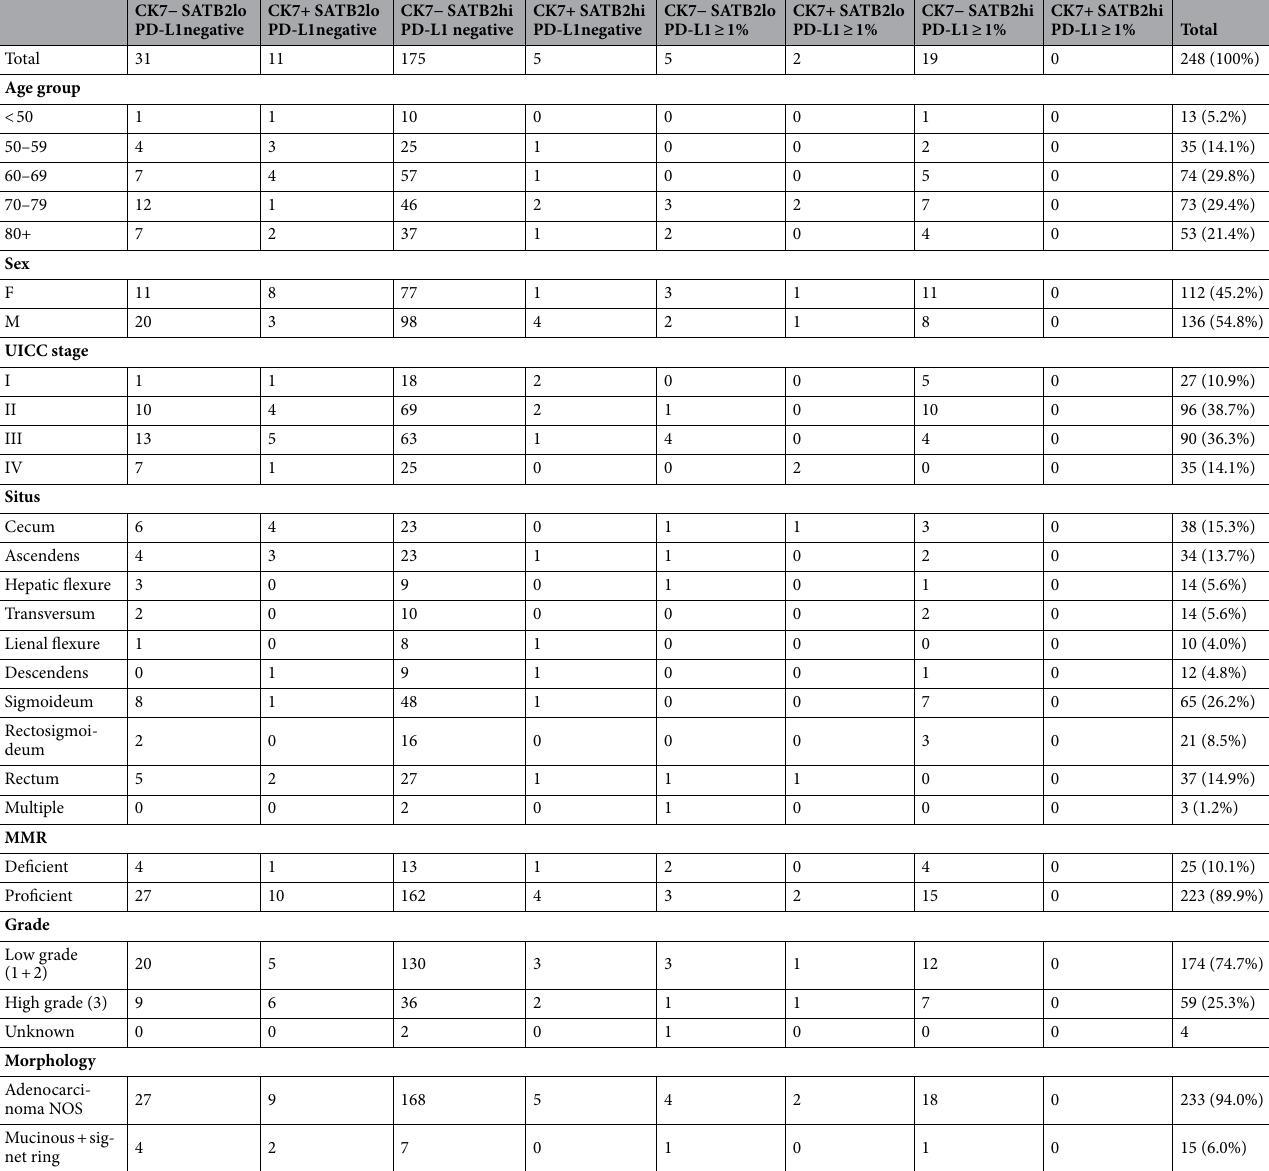
Table 2. Neoadjuvant therapy-naïve cases and all examined variables, and the number of subjects according to their CK7/SATB2/PD-L1